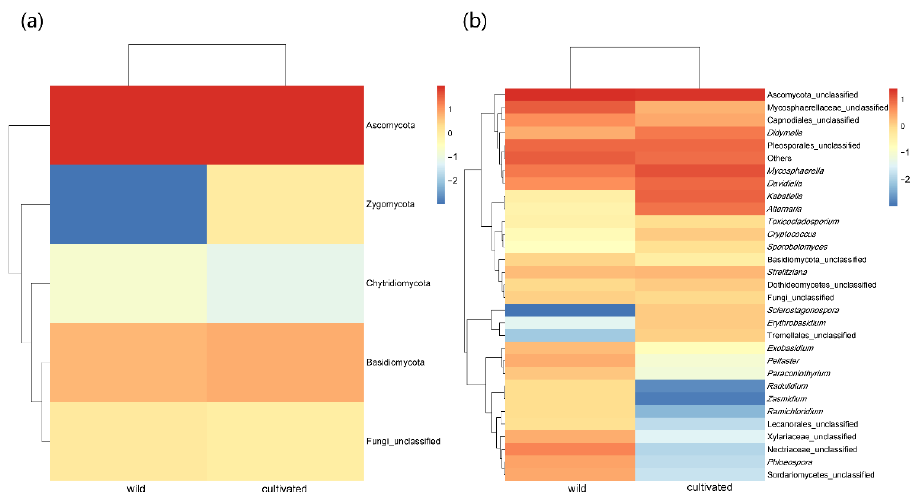
Figure 3. Heat maps of endophytic fungi in wild and cultivated L. delavayi leaves at the phylum level ( a ) and the genus level ( b ). In the figure, the gradient from blue to red represents the change of abundance from low to high. After Z-value transformation, the heat map normalizes the expression abundance of the same fungi.